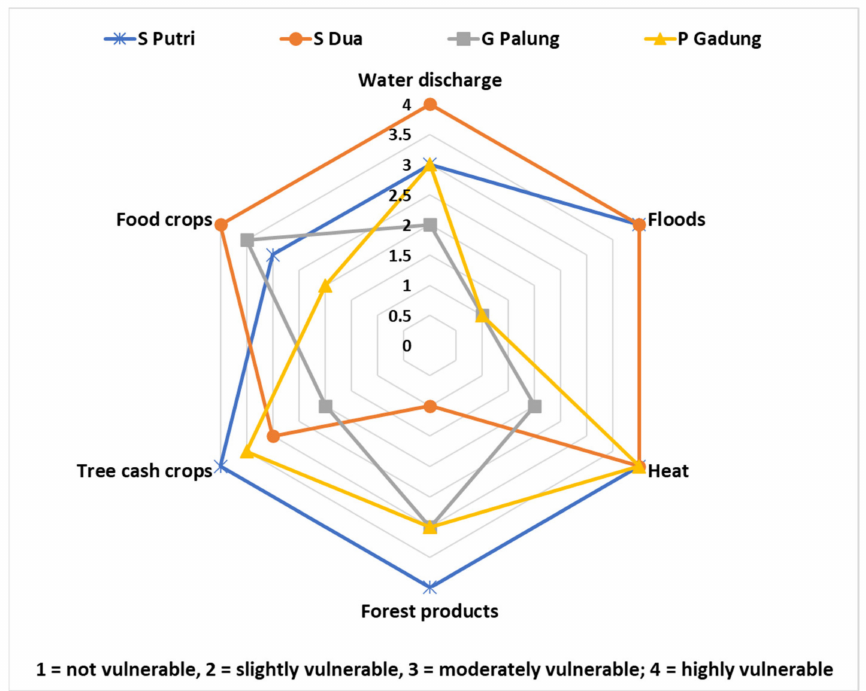
Figure 6. Perceived vulnerability scores for six impacts (see Table 3) in each landscape (S Putri = Sun- gai Putri; S Dua = Simpang Dua; G Palung = Gunung Palung; P Gadung = Pematang